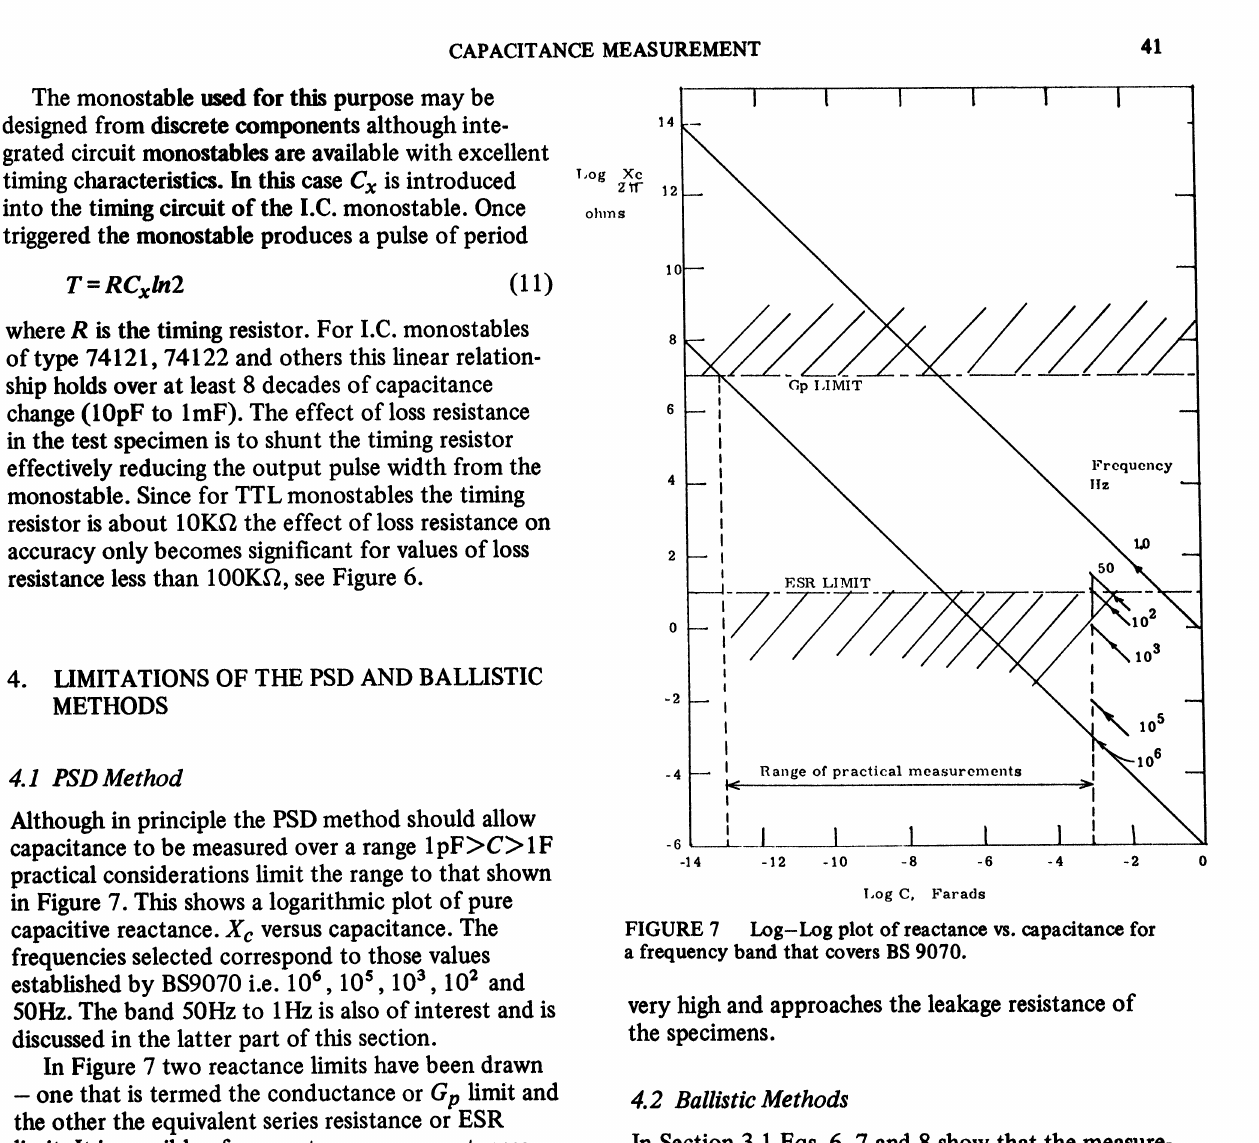
Log-Log plot of reactance vs. capacitance for a frequency band that covers BS 9070. very high and approaches the leakage resistance of the